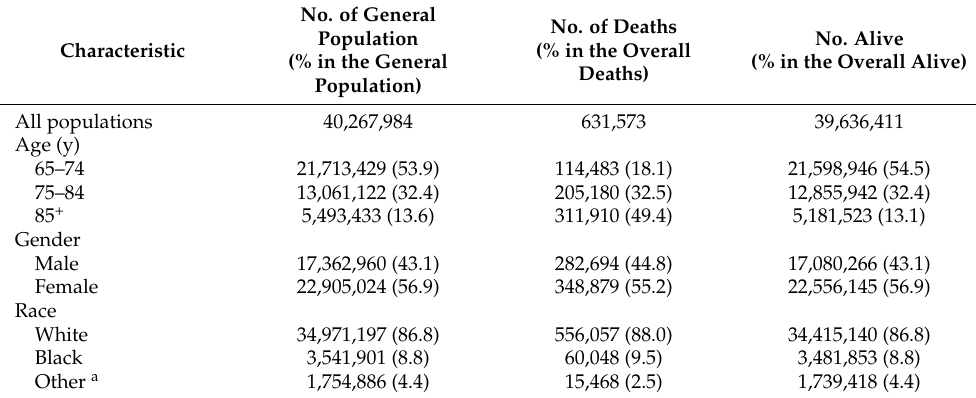
Table 2. Characteristics of the general